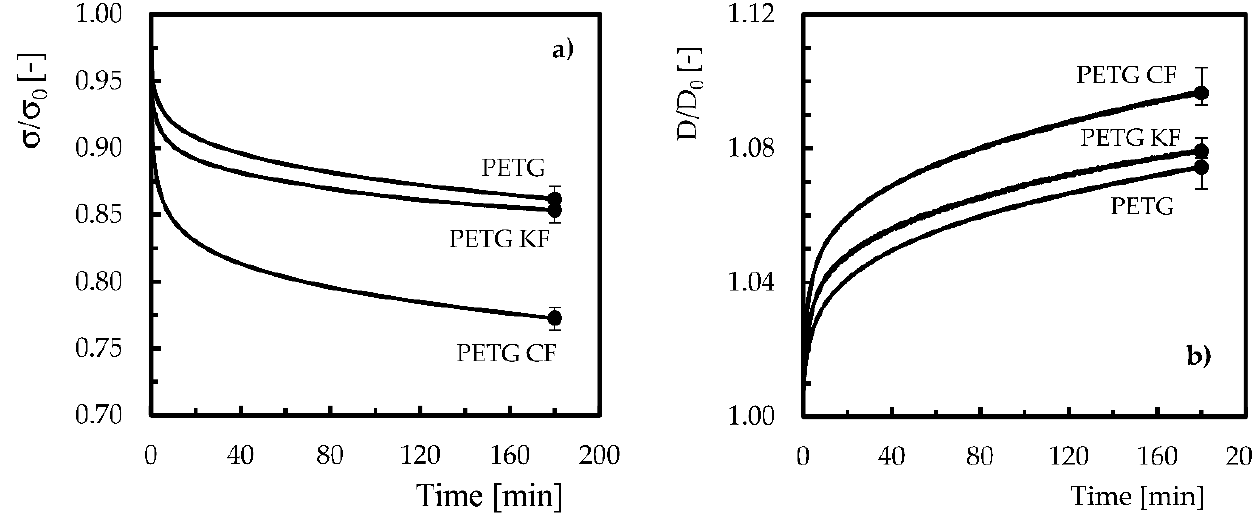
Figure 8. Comparison for 50% of the yield compressive stress for PETG composites in terms of ( a ) stress relaxation curves; ( b ) creep curves.